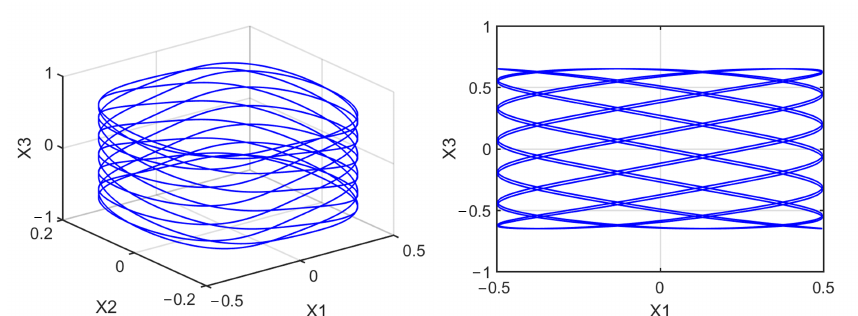
Figure A19. Periodic-13 motion of σ 1 = 8.7295.